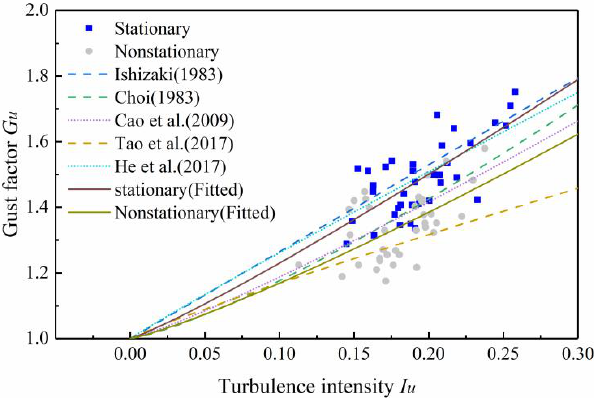
Figure 9. Stationary and nonstationary gust factors versus turbulence intensity.